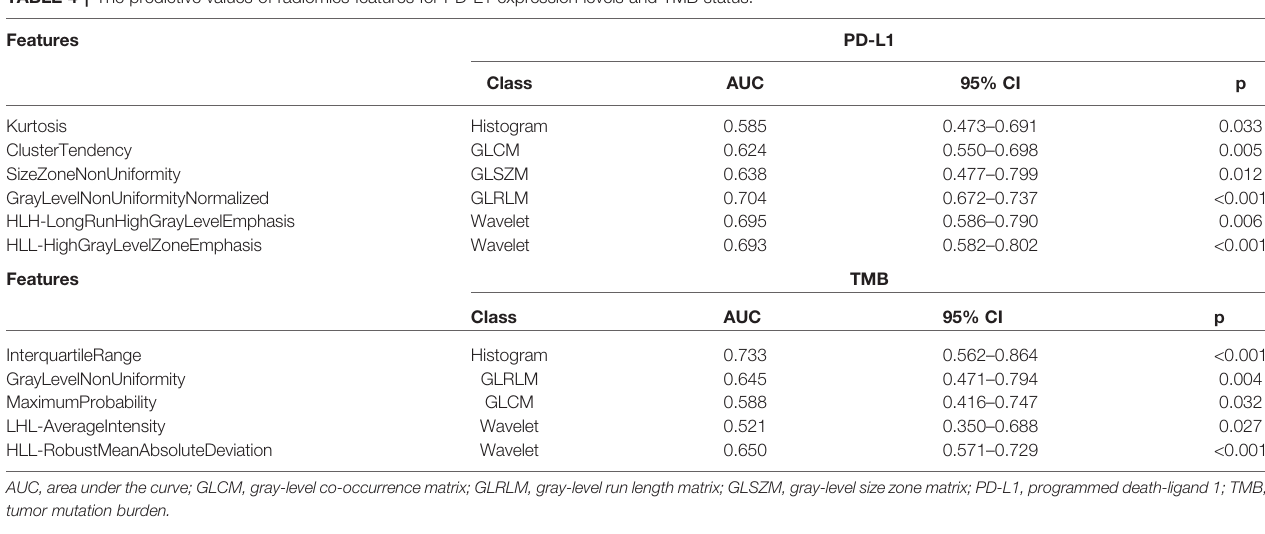
TABLE 4 | The predictive values of radiomics features for PD-L1 expression levels and TMB status.